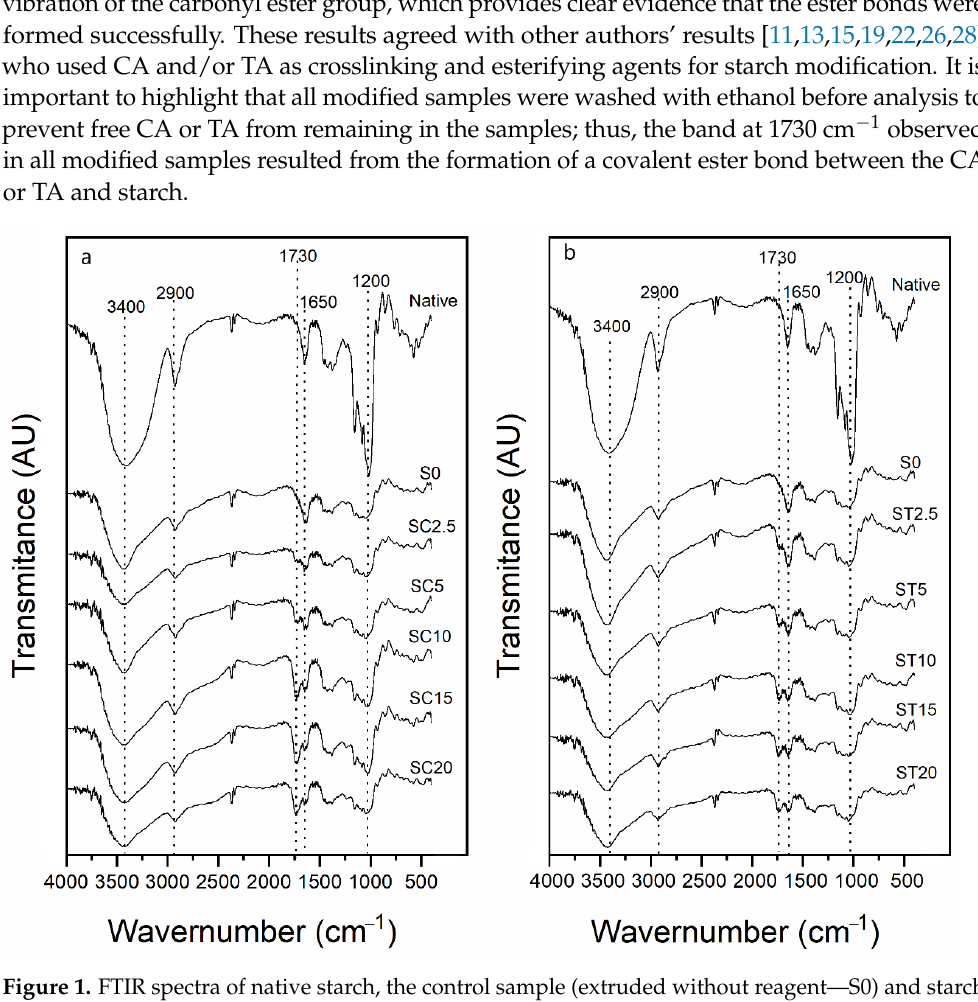
Figure 1. FTIR spectra of native starch, the control sample (extruded without reagent — S0) and starch hydrogels obtained by reactive extrusion through reaction with CA ( a ) and TA ( b ).